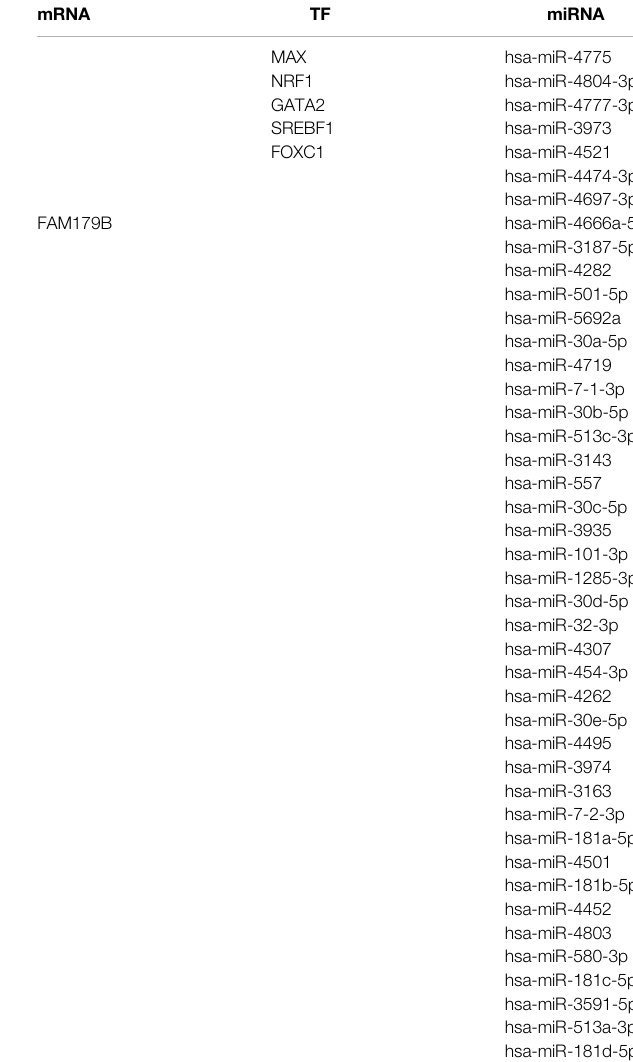
TABLE 2 | ( Continued ) The relationship in the miRNA-mRNA-TF regulatory network.